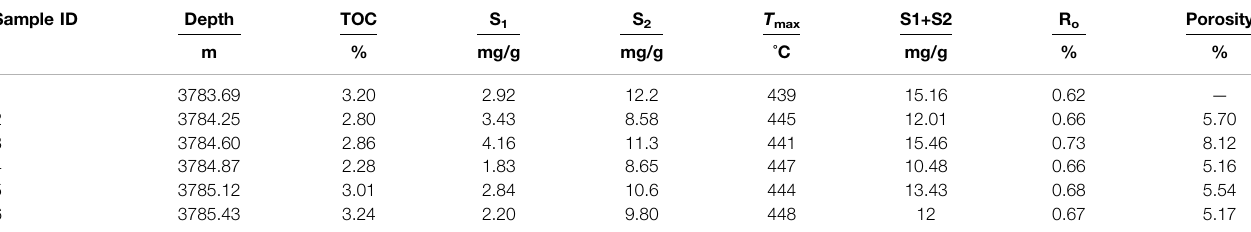
TABLE 1 | Sample information and basic properties.